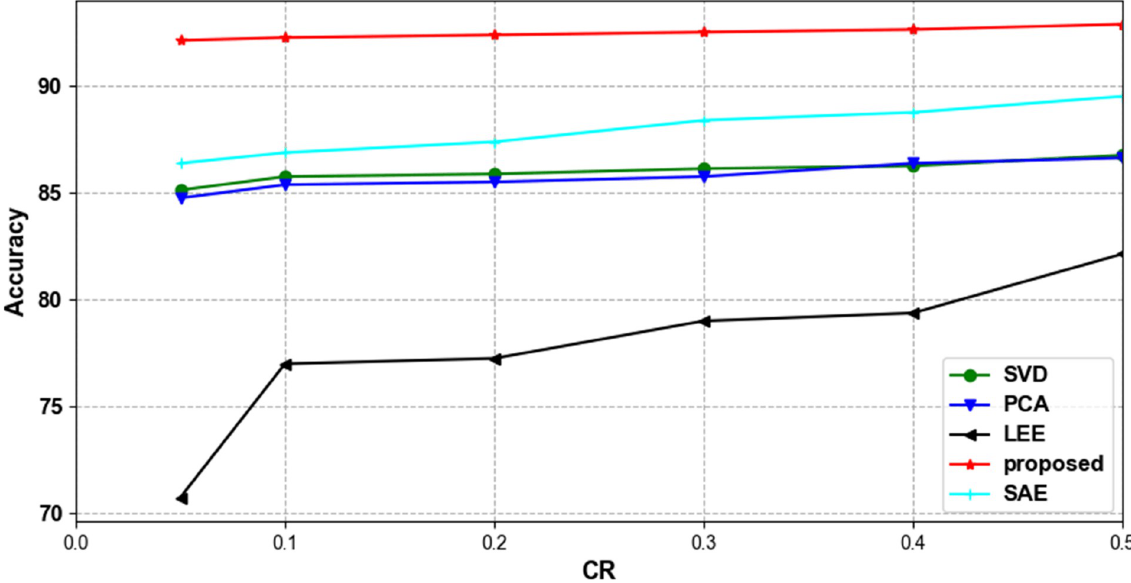
Fig 13. Accuracy trends using different compression methods at different compression ratios in the TianChi ECG signal database.